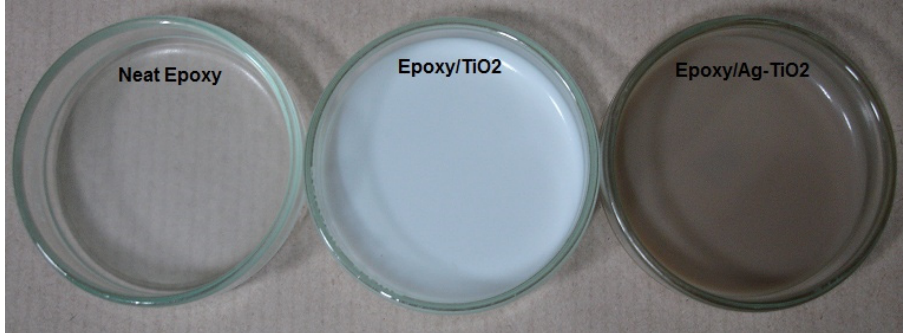
Figure 1. Assay petri dishes spin coated with neat epoxy, epoxy/TiO 2 and epoxy/Ag-TiO 2